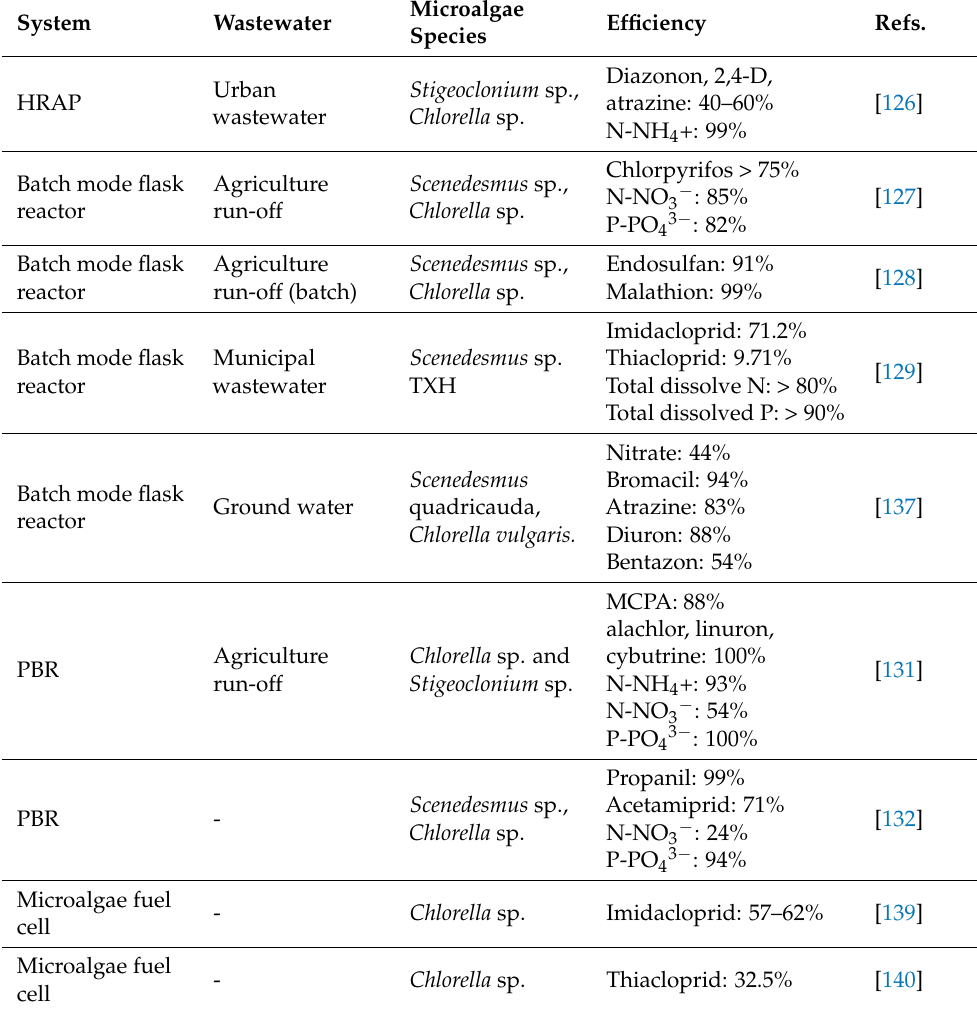
Table 1. Summary of pesticide and nutrient removal efficiency through microalgal